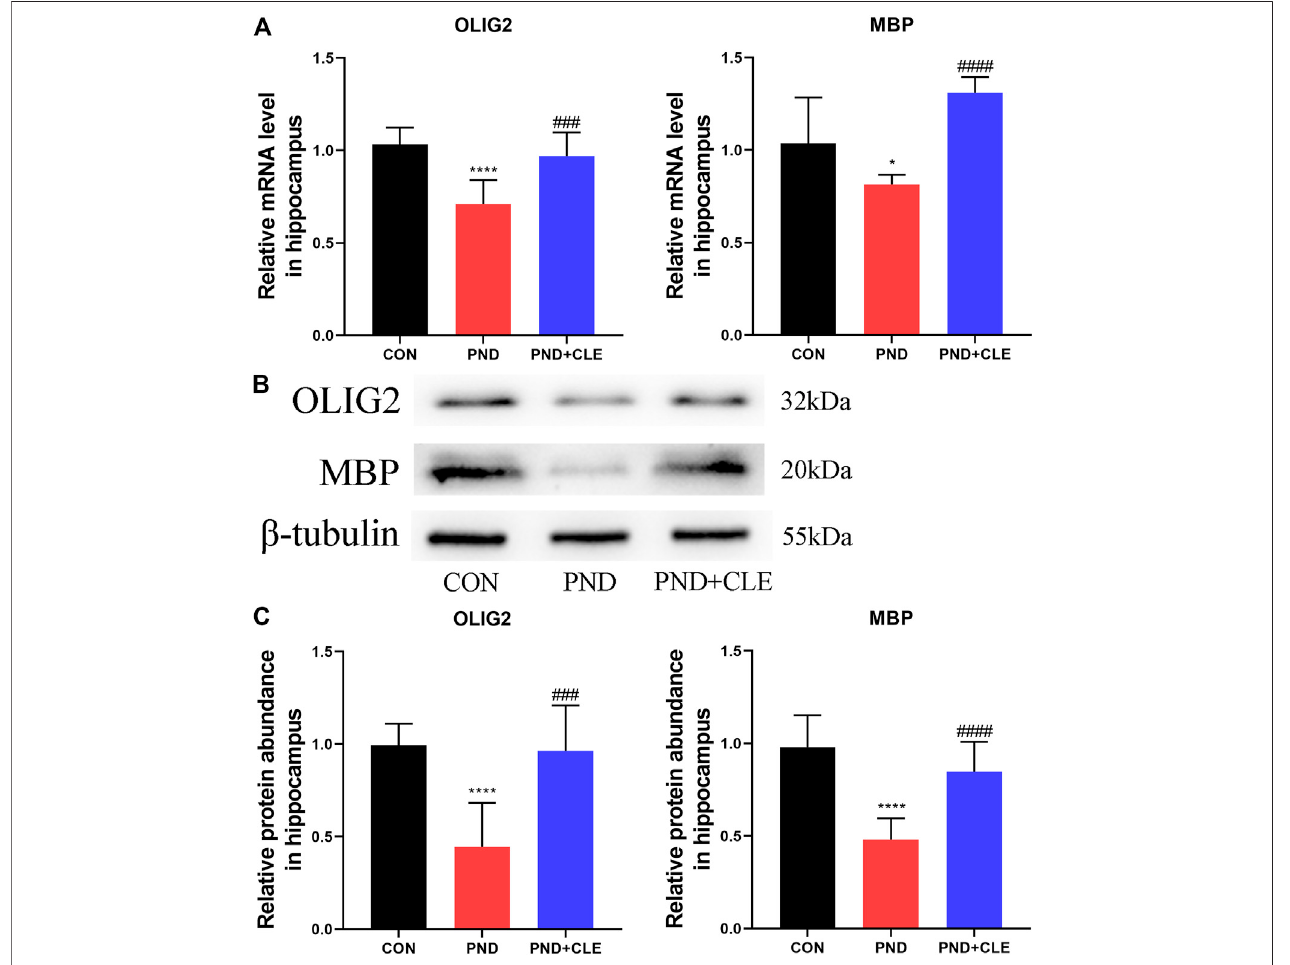
FIGURE 5 | Effects of clemastine on expression levels of OLIG2 and MBP in hippocampus of aged mice after anesthesia and surgery. ( A ) Relative mRNA expressions of OLIG2 and MBP, normalized to that of the GAPDH internal control. ( B ) Representative western blot images of OLIG2 and MBP. ( C ) Relative protein expressionsofOLIG2and MBP, normalized tothatofthe β -tubulin internal control.Thedataarepresentedasmean ± S.D.( n (cid:1) 10miceper group). * p < 0.05compared with the CON group. **** p < 0.001 compared with the CON group. ### p < 0.005 compared with the PND group. #### p < 0.001 compared with the PND group.